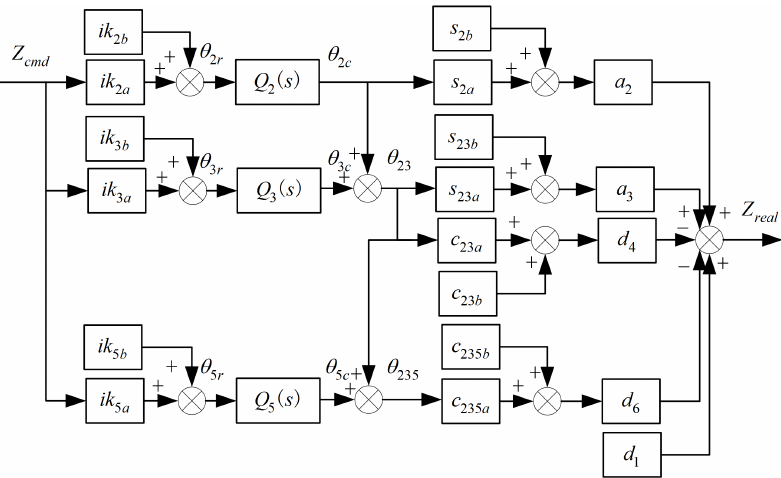
Figure A1. The structure of the identified robot manipulator